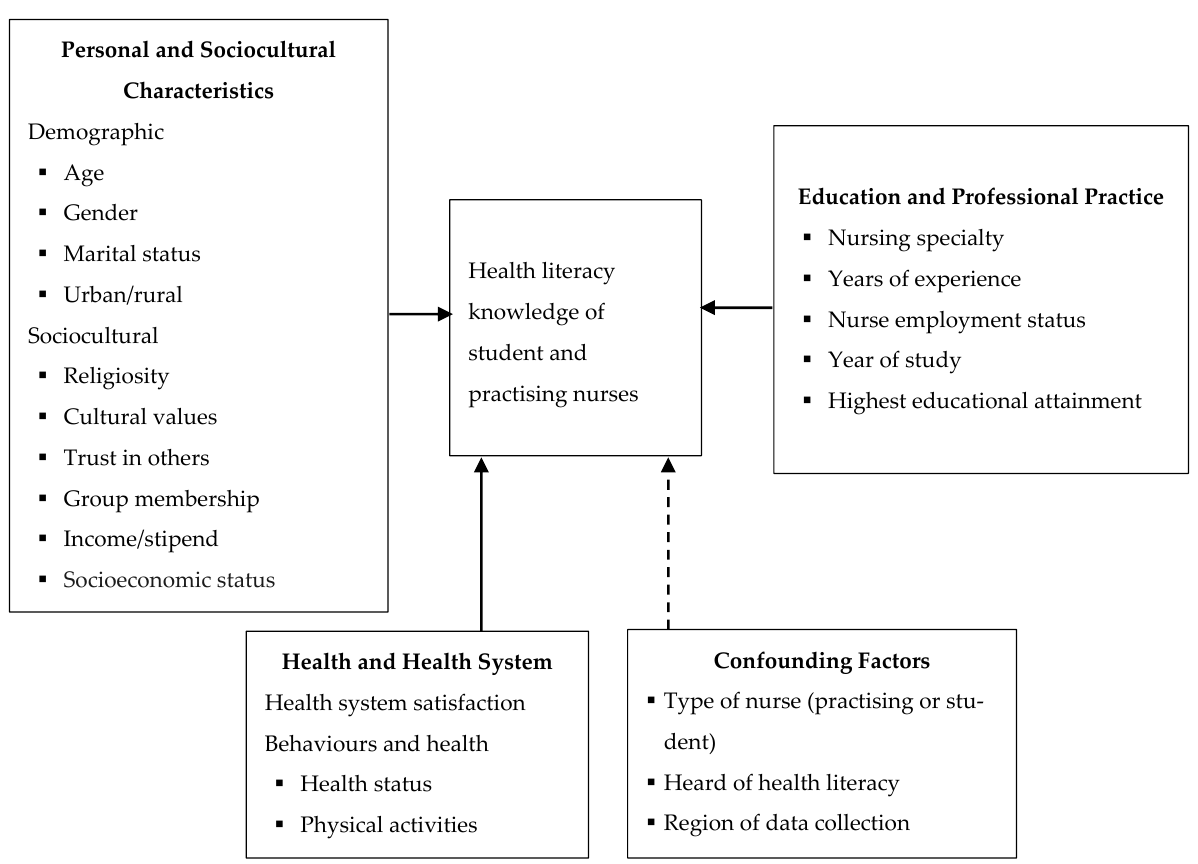
Figure 1. Conceptual framework of the correlates of health literacy knowledge of student nurses and practising nurses. Source: Adapted from the Conceptual Framework for Health Literacy [10].